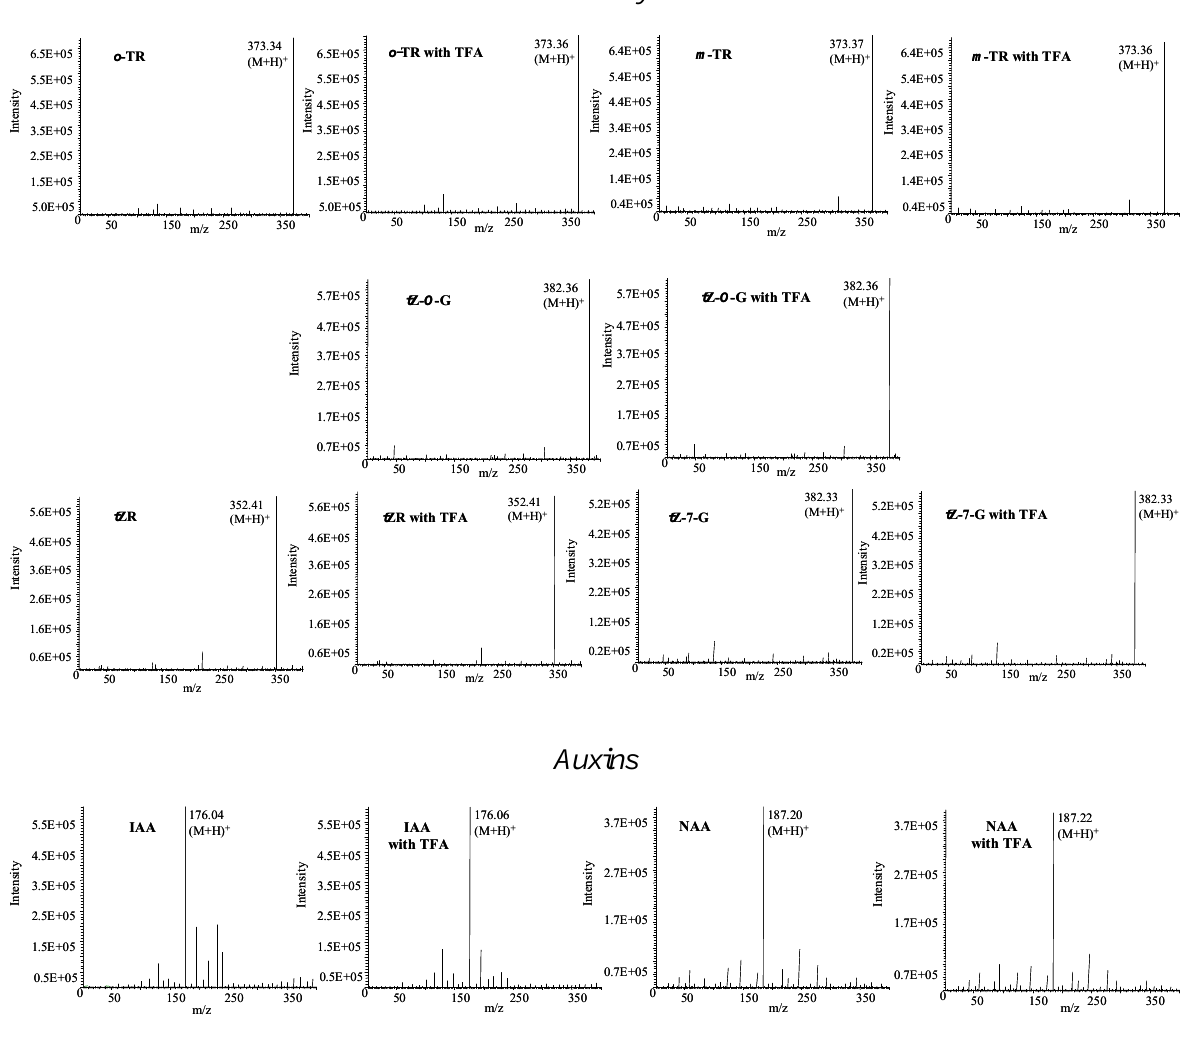
Figure 6 . Cont. Metabolites of